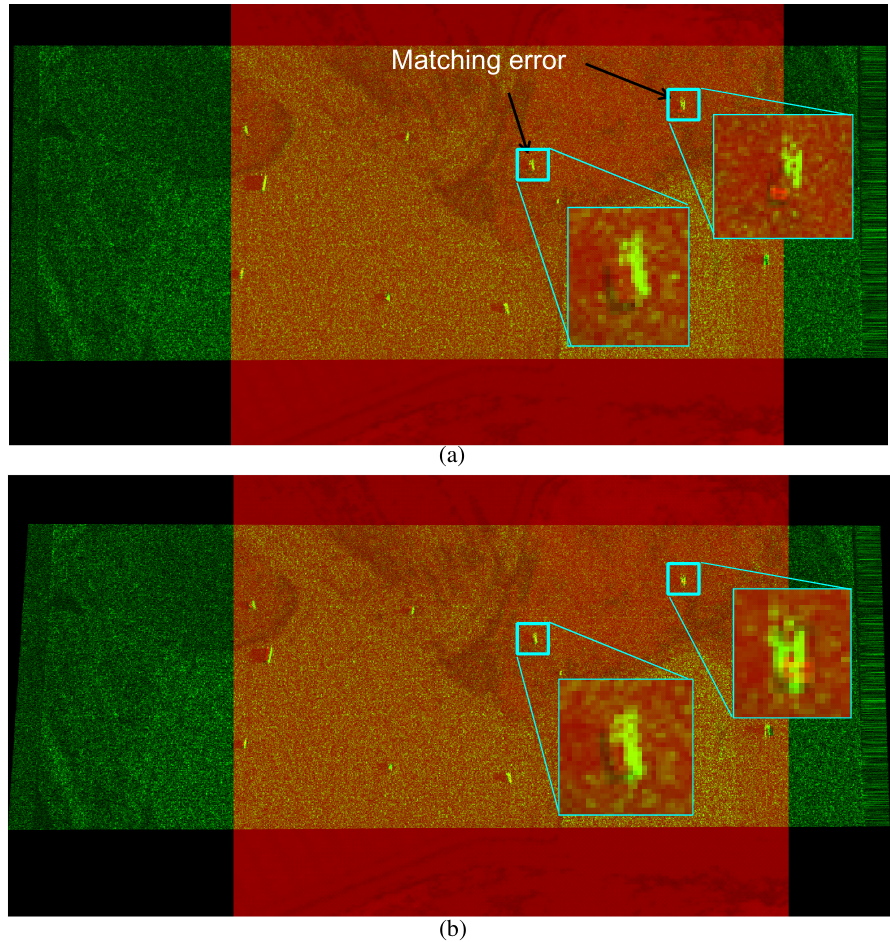
Figure 16. Comparisons of the image registration using ( a ) initial homography estimated by a brute-force search from the target points; ( b ) additionally optimized homography by the proposed